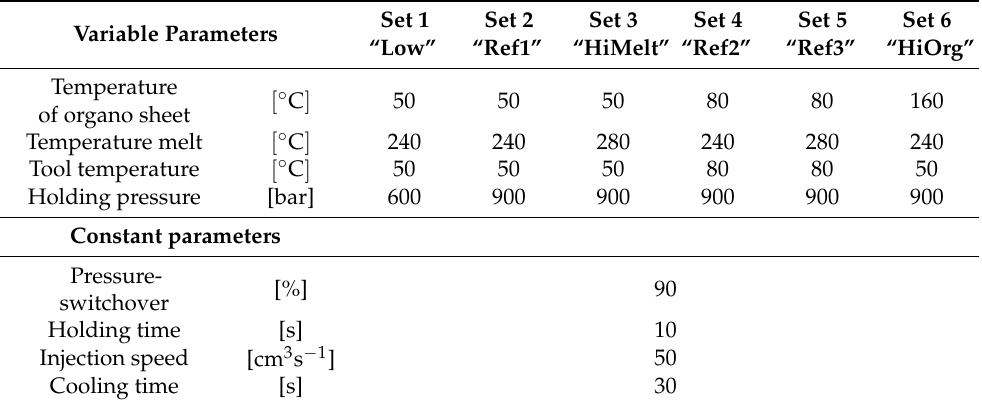
Table 1. Process parameter sets for injection moulding of cross-tension test specimen and